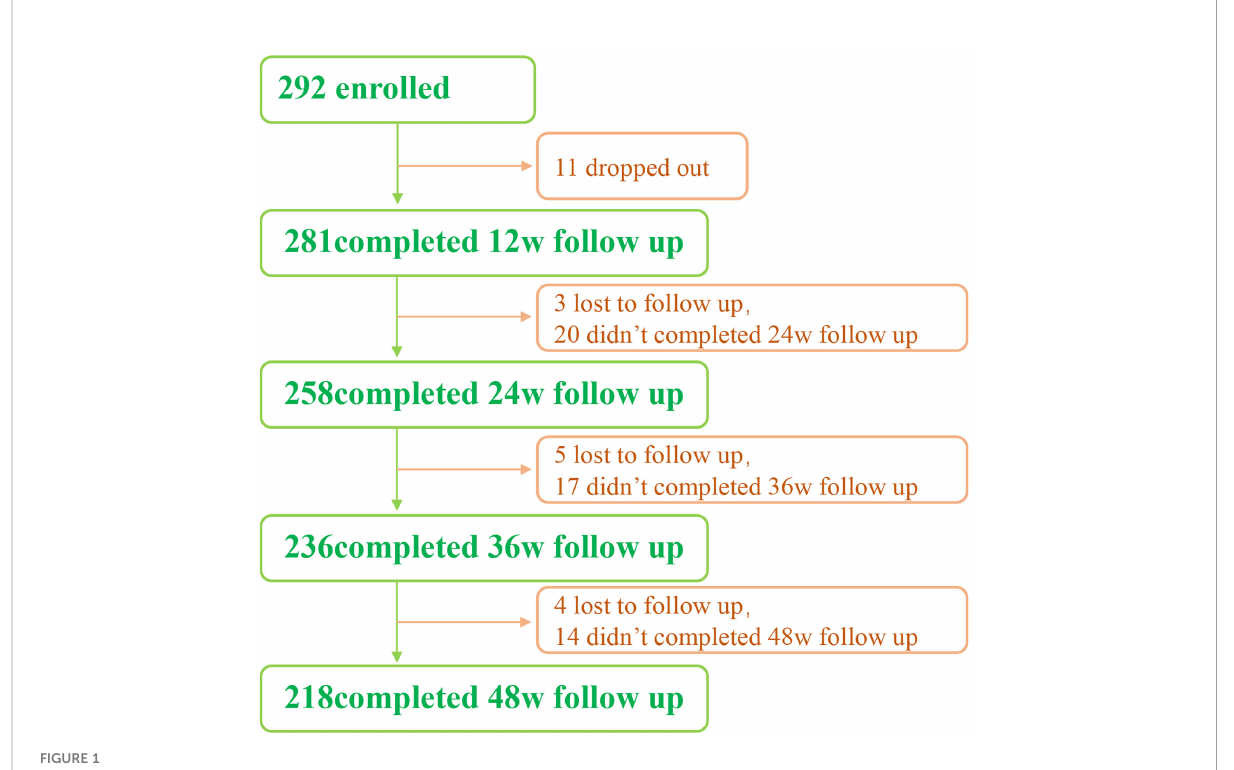
FIGURE 1 Flow chart of patients enrolled in this